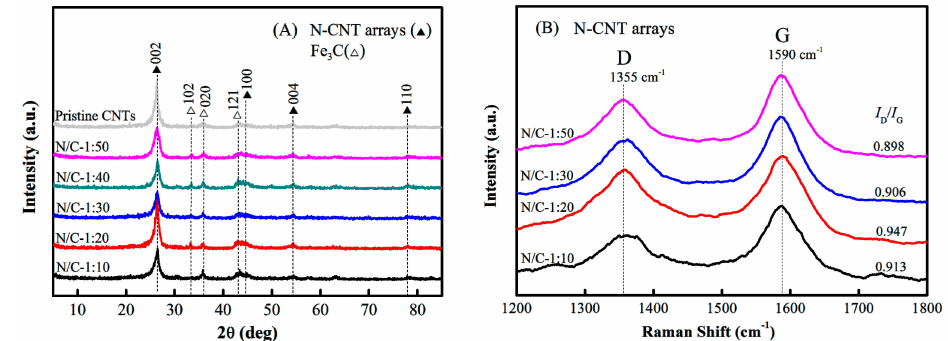
Figure 3. ( A ) X-ray di ff raction (XRD) patterns and ( B ) Raman spectra of the N-CNT arrays and pristine CNT